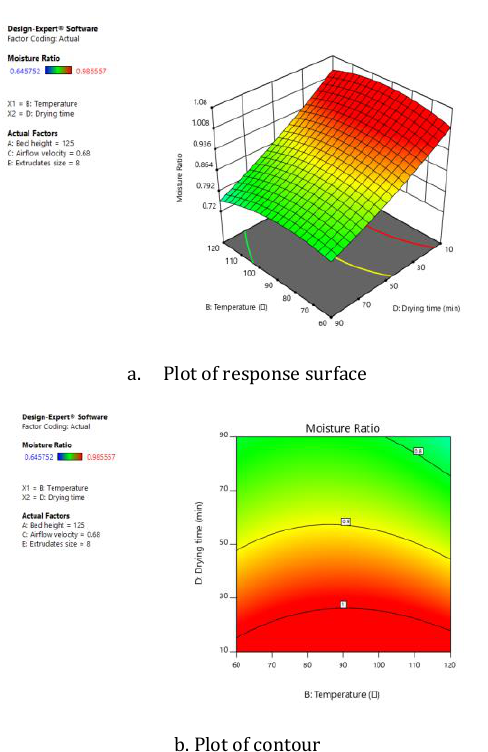
Figure 4: 3-D representation of the interaction between temperatue and drying time at 6mm extrudates size on moisture